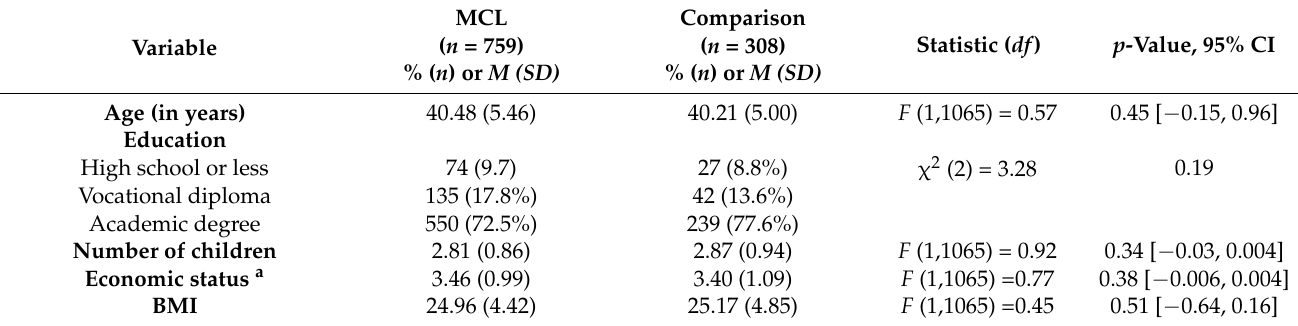
Table 1. Demographic characteristics of the Mamanet Cachibol League group and the comparison